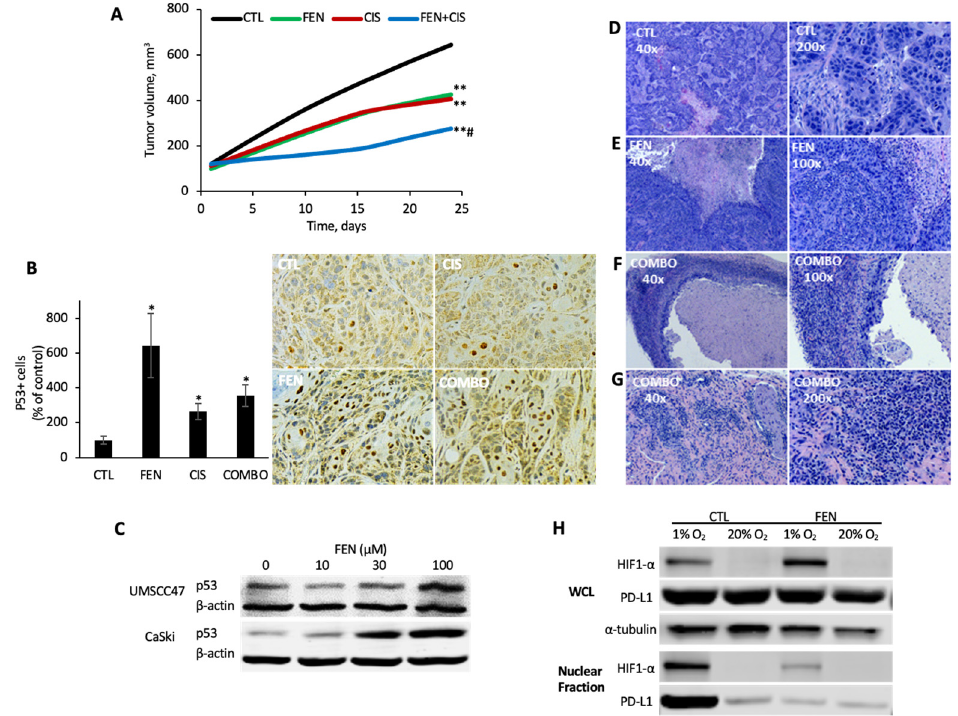
Figure 6. Fenofibrate inhibits in vivo tumorigenicity, promotes p53 accumulation, and reprograms the tumor-immune microenvironment. ( A ) UMSCC47 xenograft model. UMSCC47 cells were implanted into the flanks of athymic nude mice and tumors were allowed to develop without intervention. Tumor-bearing mice (~100 cm 3 ) were randomized to four treatment arms: control (CTL), fenofibrate (FEN; 200 mg/kg PO, 5 times/week), cisplatin (CIS; 2 mg/kg IP; once weekly), or fenofibrate + cisplatin (COMBO). ** FEN or CIS vs. CTL, p < 0.001 or COMBO vs. CTL, p = 0.0001; # COMBO vs. FENO or CIS, p = 0.0001. ( B ) p53 immunohistochemistry. p53 levels were analyzed in harvested UMSCC47 xenograft tumors and tumor cells with strong nuclear staining was scored as p53+. A representative IHC image for each experimental condition is shown (200 × ). * p < 0.01. ( C ) p53 levels. Immunoblot for p53 protein levels following control or fenofibrate treatment in UMSCC47 cells. Uncropped immunoblots are available in File S1. ( D – G ) Hematoxylin- and eosin- stained tumor sections. Representative tumor sections illustrating notable morphological features, at low power (40×; left) and higher power magnification (100–200×; right). ( H ) HIF1 α and PD-L1 levels. Immunoblot for nuclear HIF1 α and PD-L1 levels under normoxic (20% O 2 ) or hypoxic (1% O 2 ) conditions with control or fenofibrate treatment in UMSCC47 cells. Uncropped immunoblots are available in File S1.